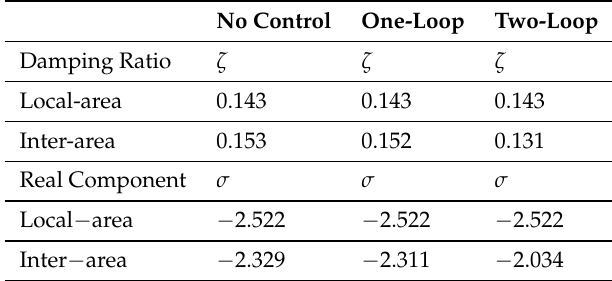
Table 3. Scenario 2—Heavy